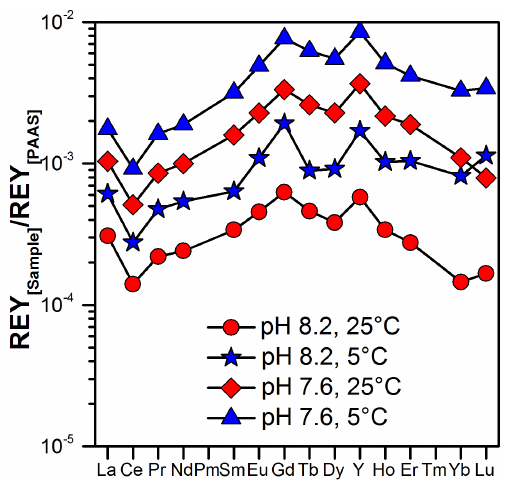
Figure 9. Modeled REY SN patterns of hypothetical M. edulis shells patterns of North Sea wa- SN from the ODAS site for different pH and temperature conditions in ambient